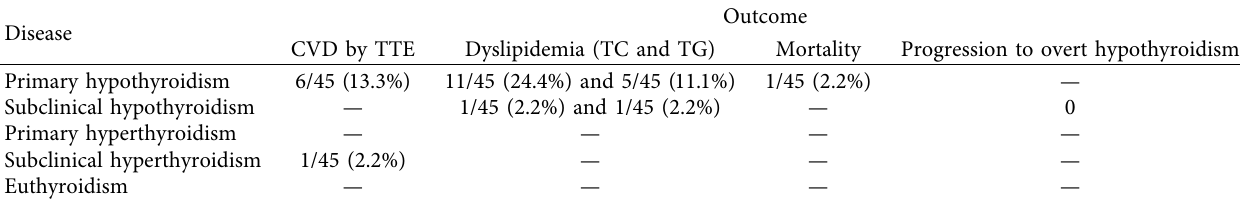
Table 7: Distribution of outcomes in thyroid dysfunction and kidney disease.